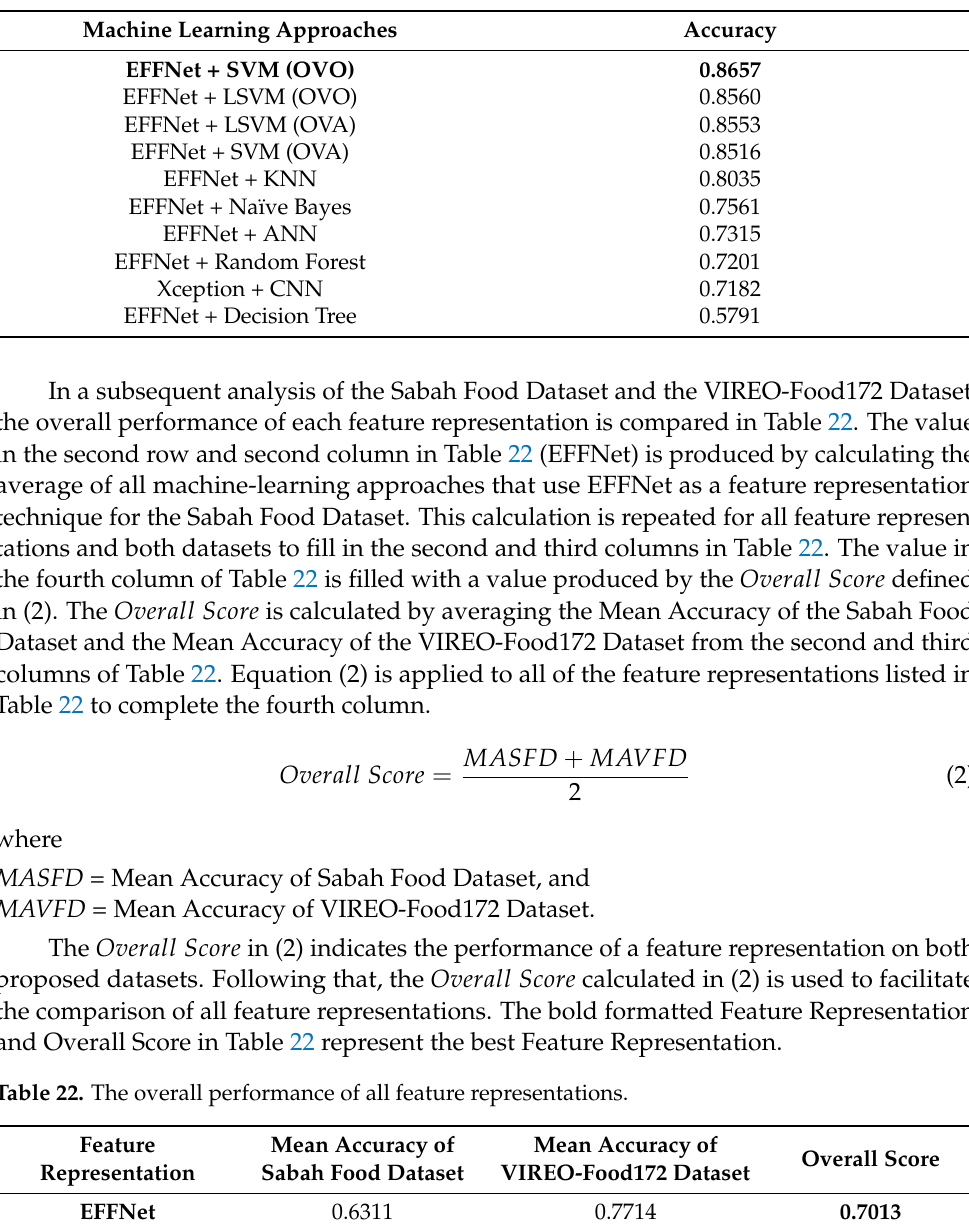
Table 21. The highest accuracy based on classifier for VIREO-Food172 Dataset.